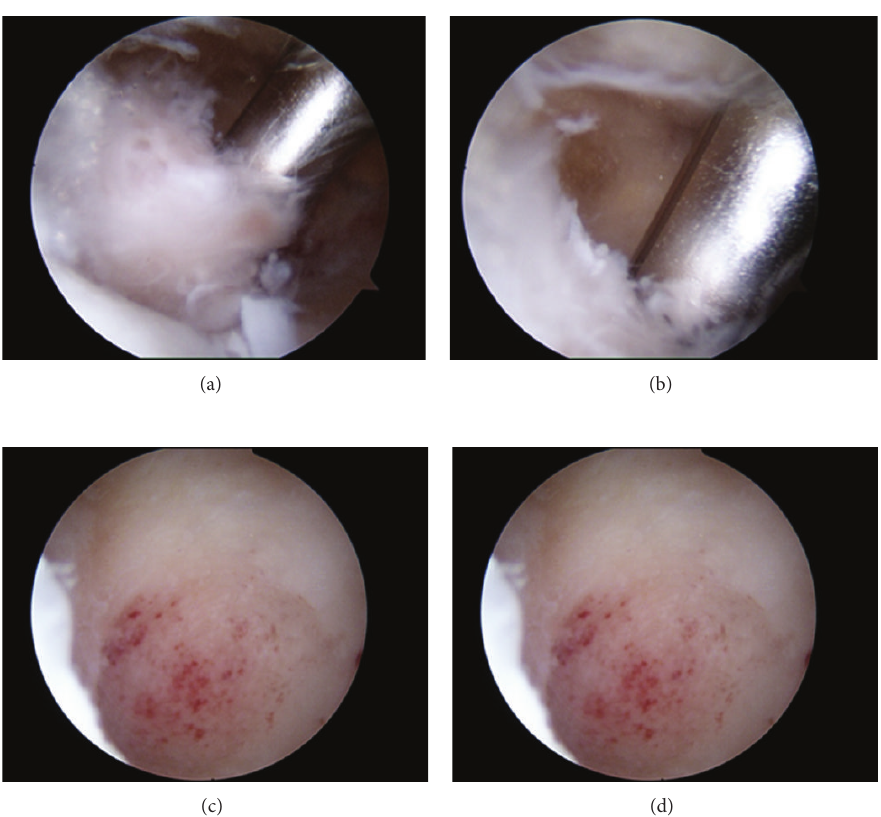
Figure 6: (a) Arthroscopic removal of juxtaarticular osteoid osteoma of the olecranon fossa. (b) Removal of the hypertrophic synovium. ((c) and (d)) The crater at the site of the lesion after its total